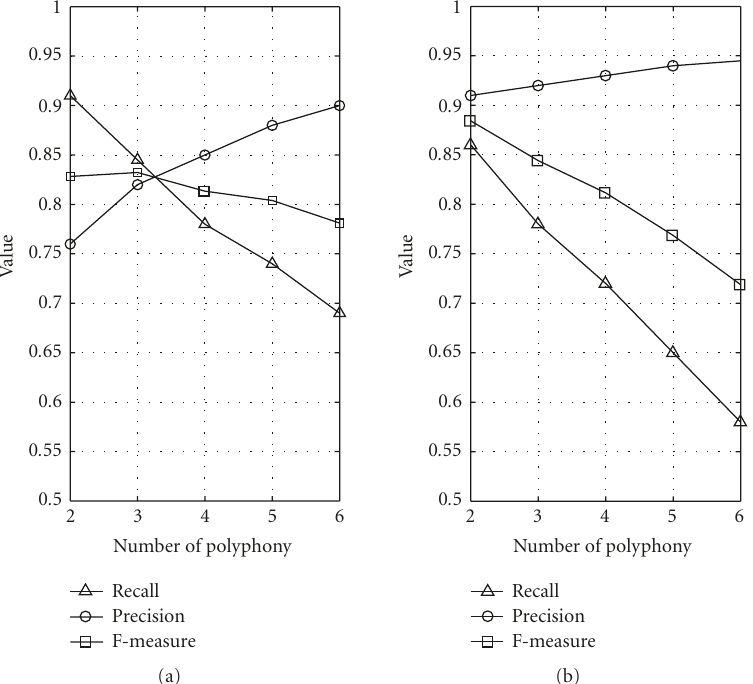
Figure 7: F-Measure, Recall, and Precision results for the proposed method with di ff erent parameters. (a) Better Recall, when parameters: A 1 = 8, A 2 = 8, SI(2) = 10, SI(3) = 10, SI(4) = 5. (b) Better Precision, when parameters: A 1 = 12, A 2 = 12, SI(2) = 15, SI(3) = 15, SI(4) = 10.